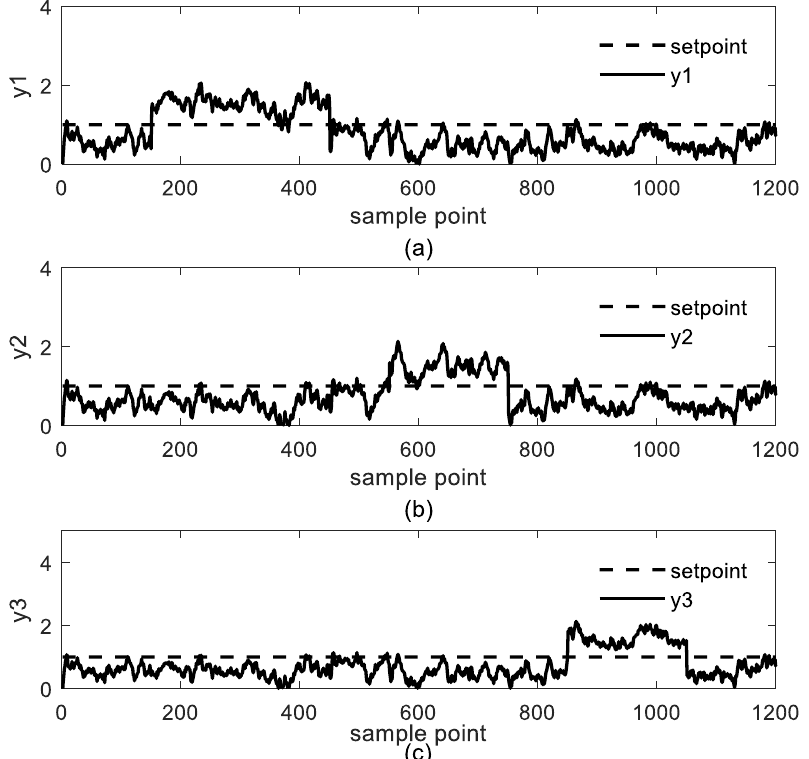
Figure 16. The simulation result of MSDP with white noise: ( a ) y 1 —production; ( b ) y 2 —slurry polymer; ( c ) y 3 —catalyst efficiency.